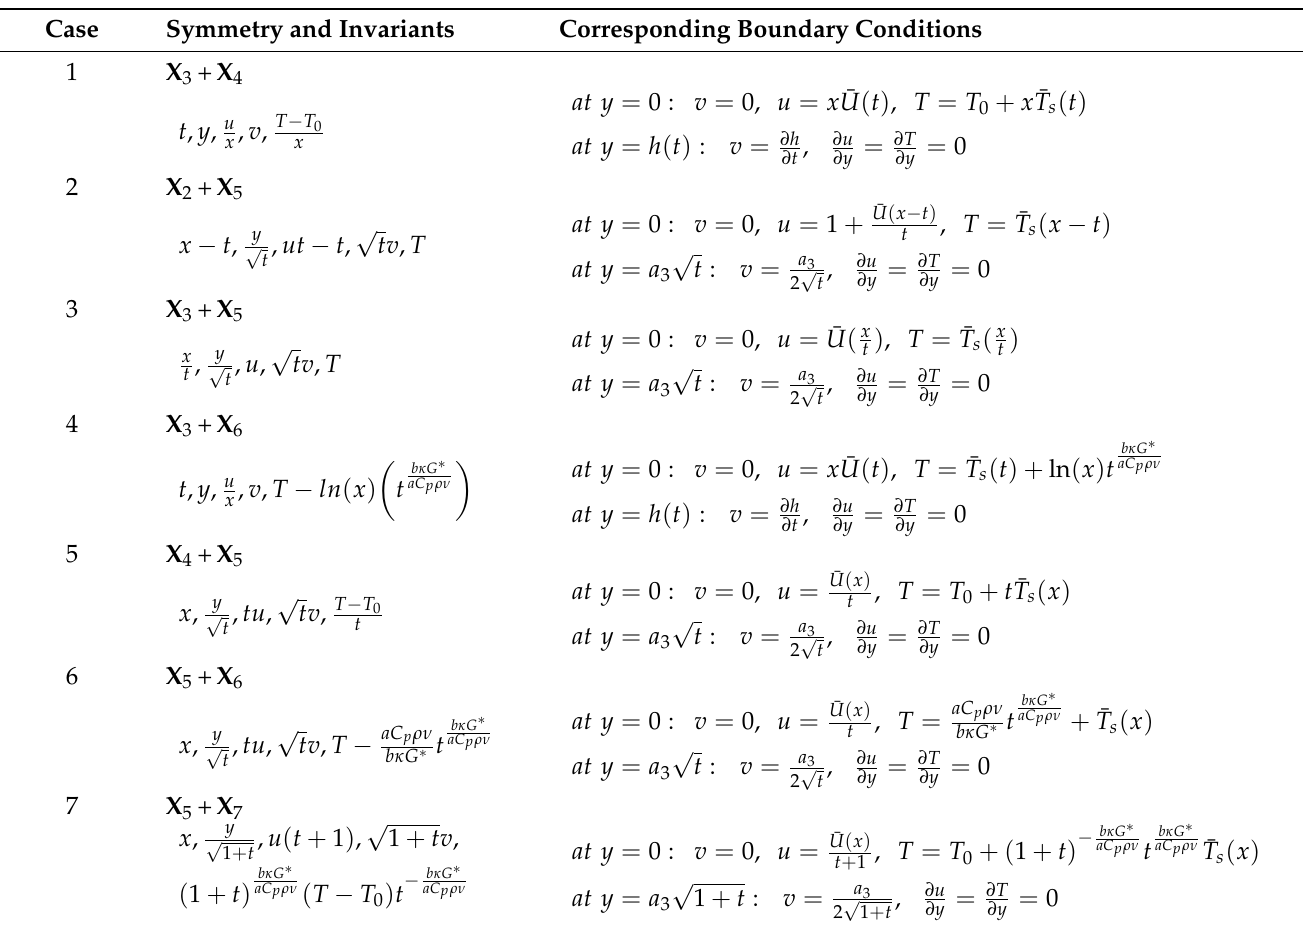
Table 2. First invariants for similarity